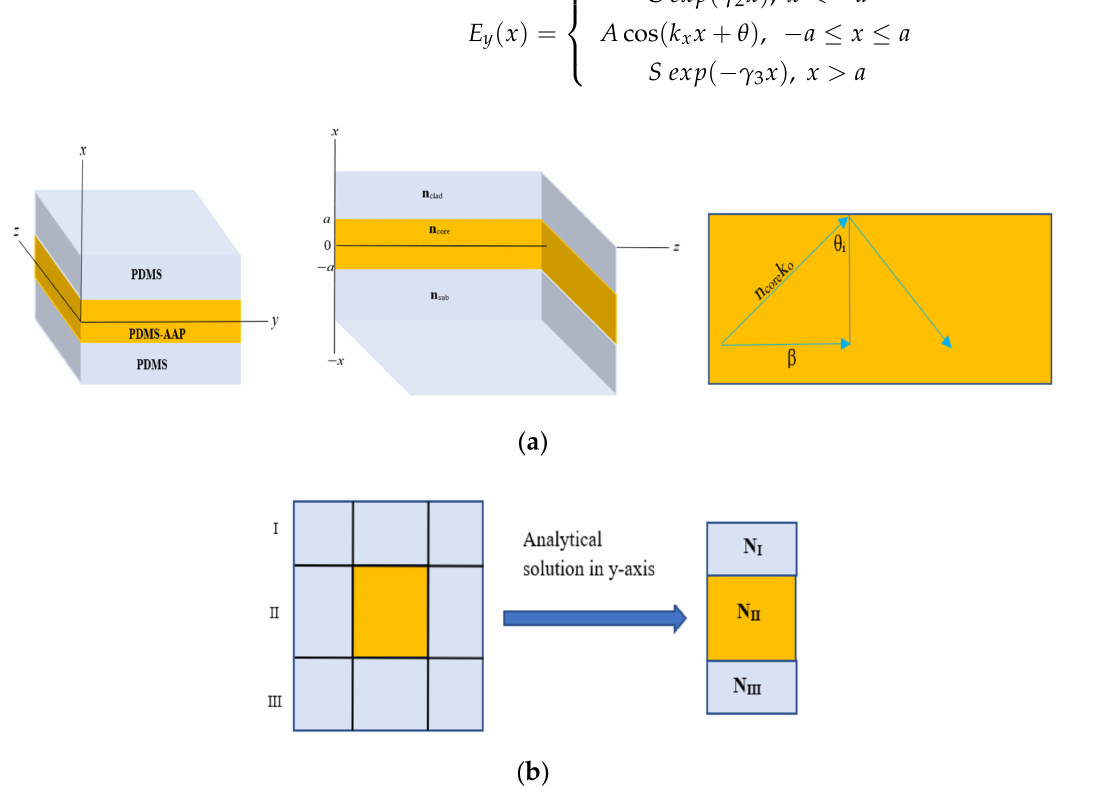
Figure 3. ( a ) Planar waveguide geometry. n is refractive index of clad, core, and substrate. ( b ) Effective index scheme implemented to simulated electric filed